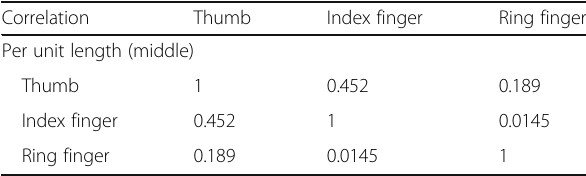
Table 5 Correlation between Thumb, Index, and Ring finger per unit area for middle